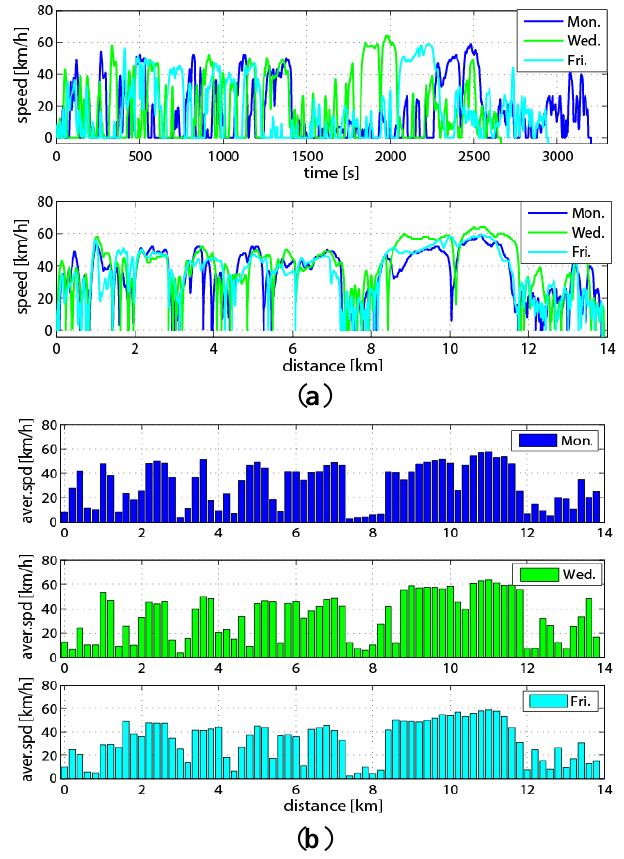
Figure 3. Traffic speed information on Monday, Wednesday, Friday in one week.